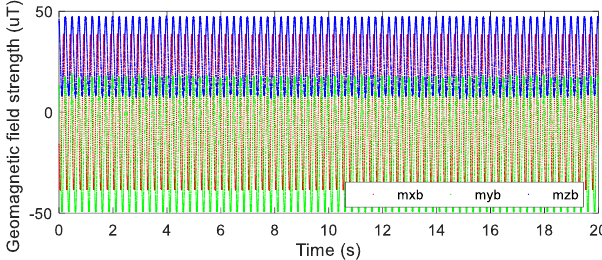
Figure 5. Simulation data of the three − axis magnetic sensor.